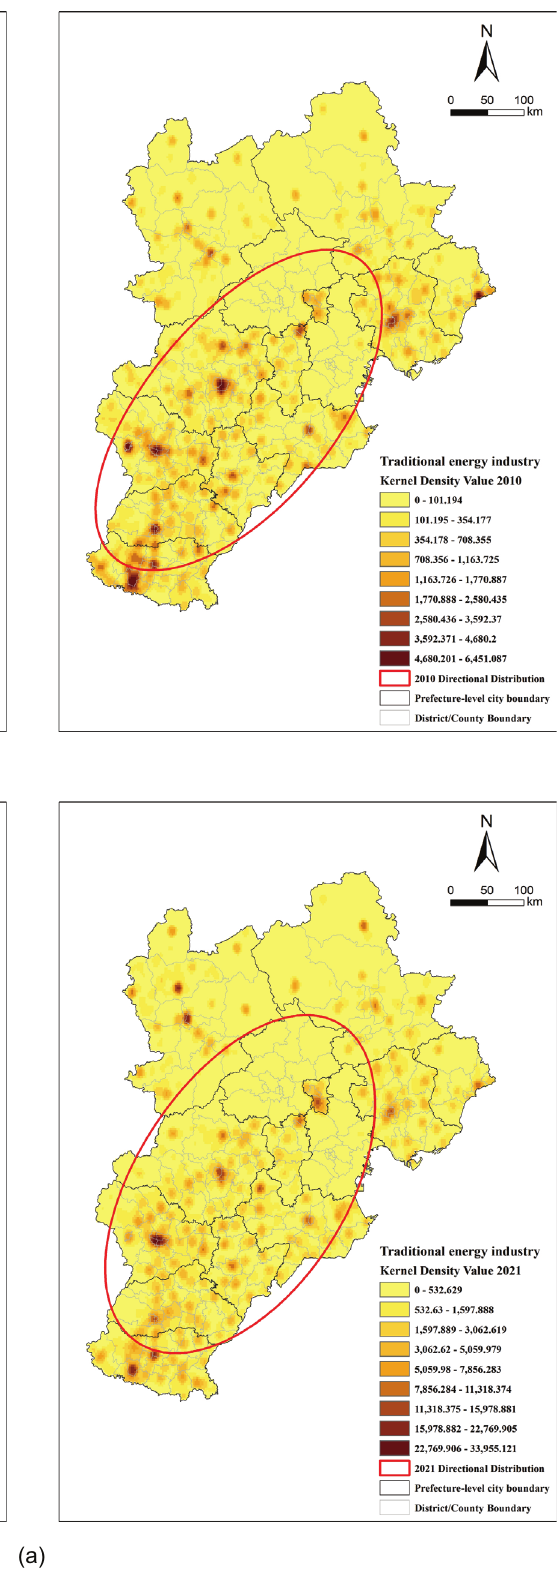
Fig. 2. Kernel density and SDE of the energy industry in 2005/2010/2015/2020. (a) Traditional energy industry in 2005/2010/2015/ 2020. (b) Renewable energy industry in